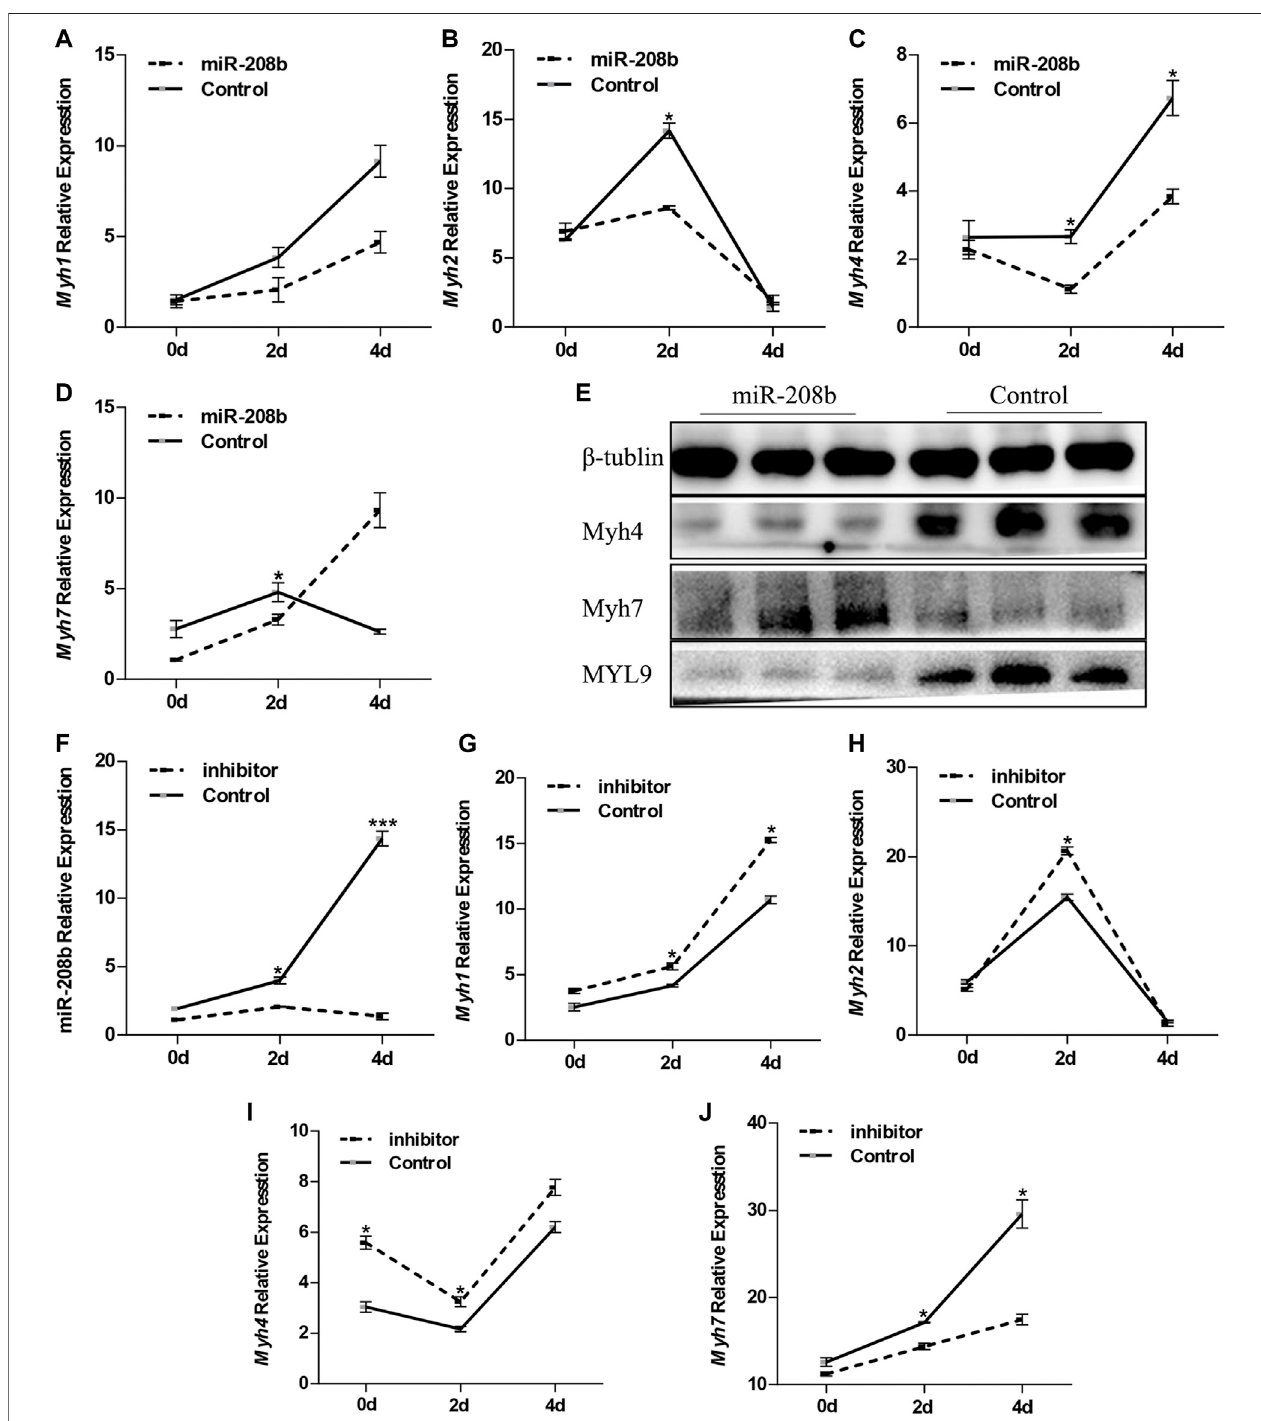
FIGURE 3 | Effect of miR-208b on MyHC gene expression during myogenic differentiation. (A – D) : relative mRNA expression levels of Myh1 (A) , Myh2 (B) , Myh4 (C) , and Myh7 (D) in C2C12 cells overexpressing miR-208b on days 0, 2, 4 of myogenic differentiation. (E) protein expression levels of Myh4, Myh7, MYL9 post 4 days of miR-208b over-expression during C2C12 myogenic differentiation. miR-208b represents the transfection of miR-208b mimics to achieve the effect of over- expression of miR-208b. (F) Relative expression level of MyHC after transfection of 100 nM miR-208b inhibitor and control on days 0, 2, 4 during differentiation. (G – J) respectivelyindicaterelativeexpressionlevelsofMyh1 (G) ,Myh2 (H) ,Myh4 (I) ,andMyh7 (J) on0,2,and4 daysofC2C12myogenicdifferentiationaftermiR-208b expression is inhibited. Statistical comparisons are performed using multiple t-tests.* p < 0.05.